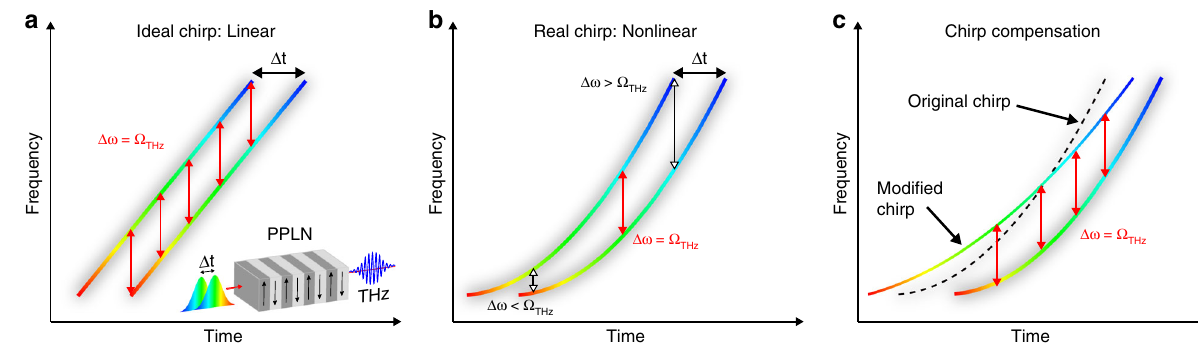
Fig. 1 Chirp-and-delay concept. a Two broadband but linearly chirped and delayed pulses provide narrow spectral features with constant instantaneous difference frequency Δ ω , which is converted in a PPLN crystal into a THz pulse of frequency Ω THz = Δ ω . b Due to higher order dispersion Δ ω varies along the pulse and limits the range where the provided difference frequency ful fi ls the phase matching condition in the PPLN. c Slightly tilting one of the pulses in time-frequency space regularises Δ ω and thereby maximises